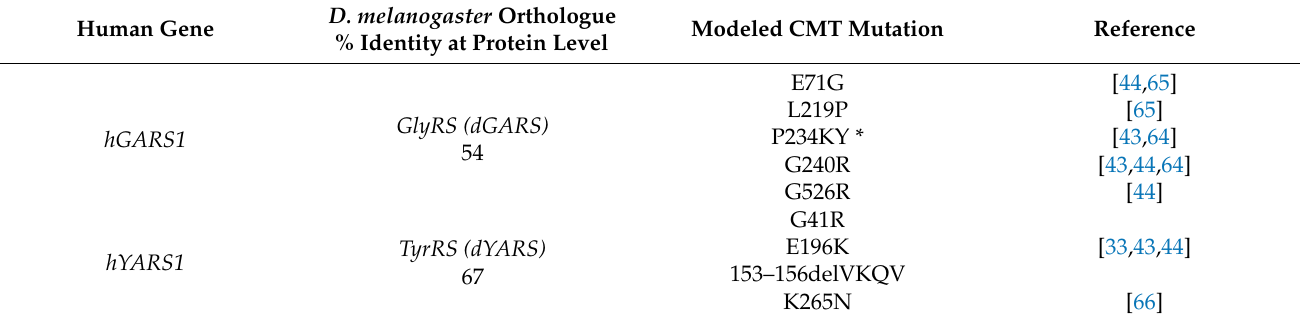
Table 2. Models for aaRS-related CMT in D. melanogaster